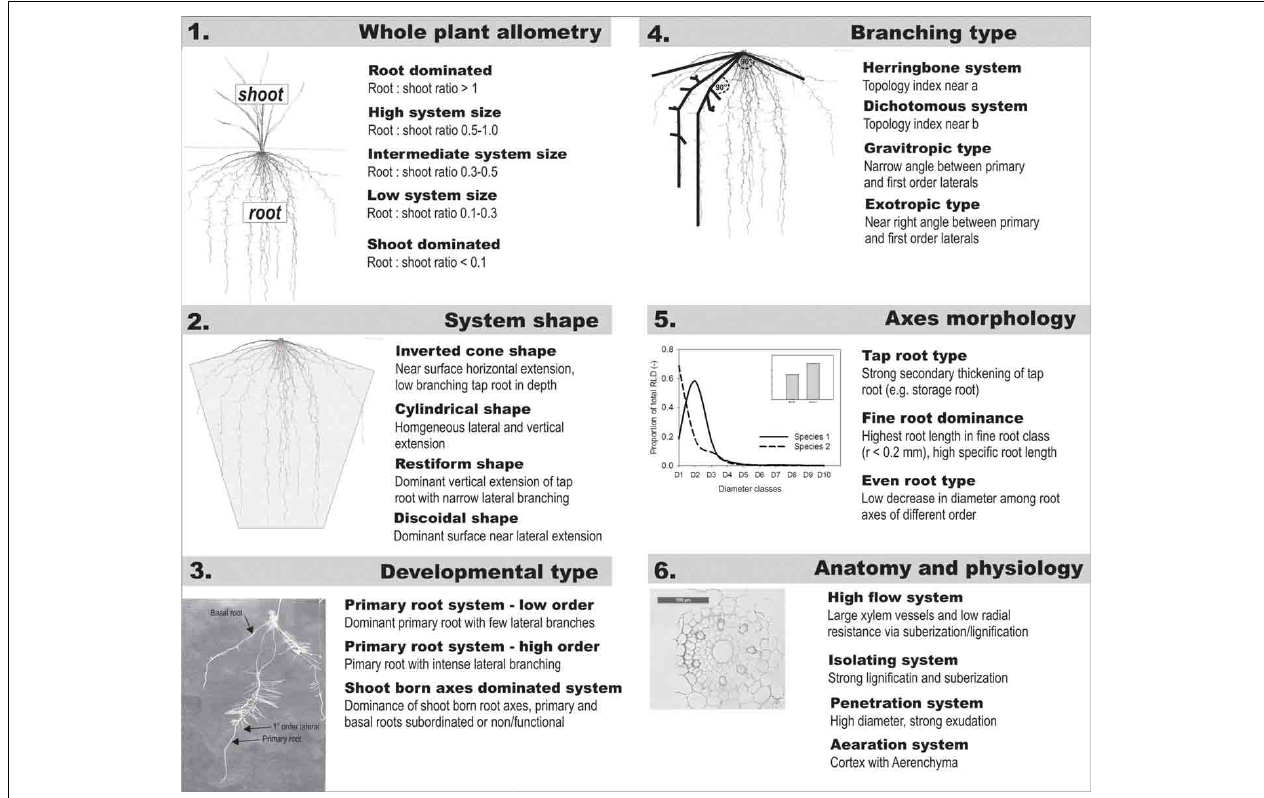
FIGURE A1 | Examples of possible descriptive categories for hierarchically ordered root traits within a comprehensive core data set to be used for classification of root system types.